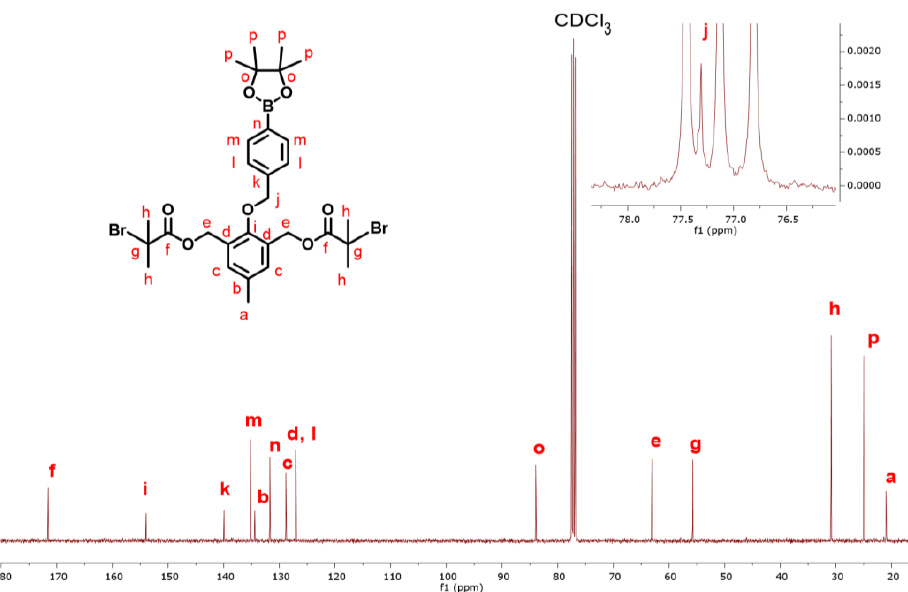
Figure 3. 13 C-NMR spectrum of the difunctional initiator (DFI) compound 4 in CDCl 3 .